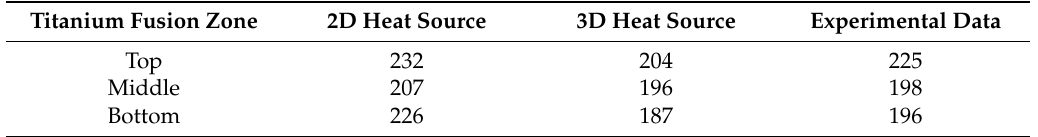
Table 6. Dimension (mm) of the fusion zone profile in the titanium side.